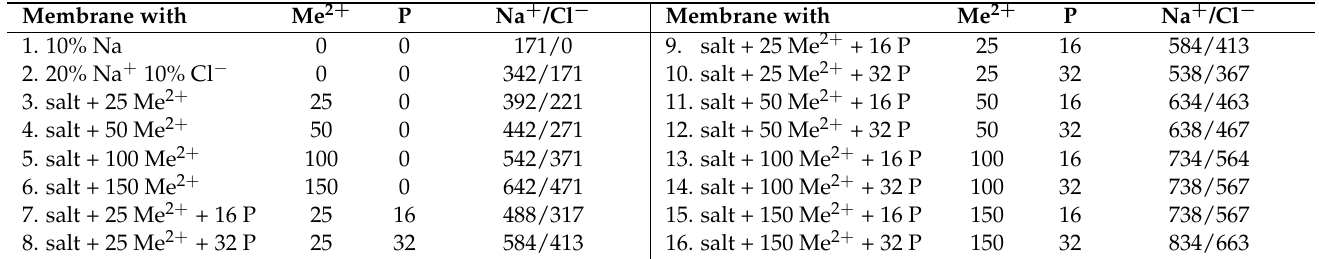
Table 2. The list of performed simulations in a box of volume 32 3 with the total number of